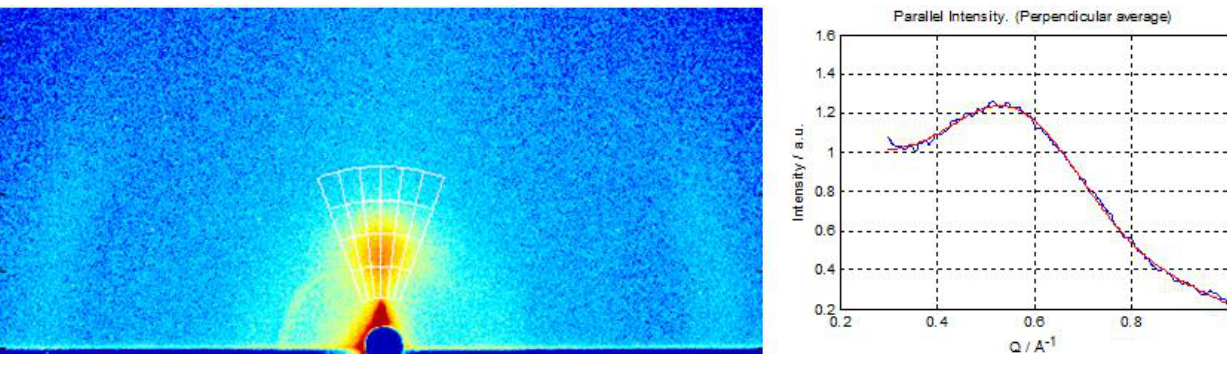
O ·(H O) film on a 2 5 2 0.3